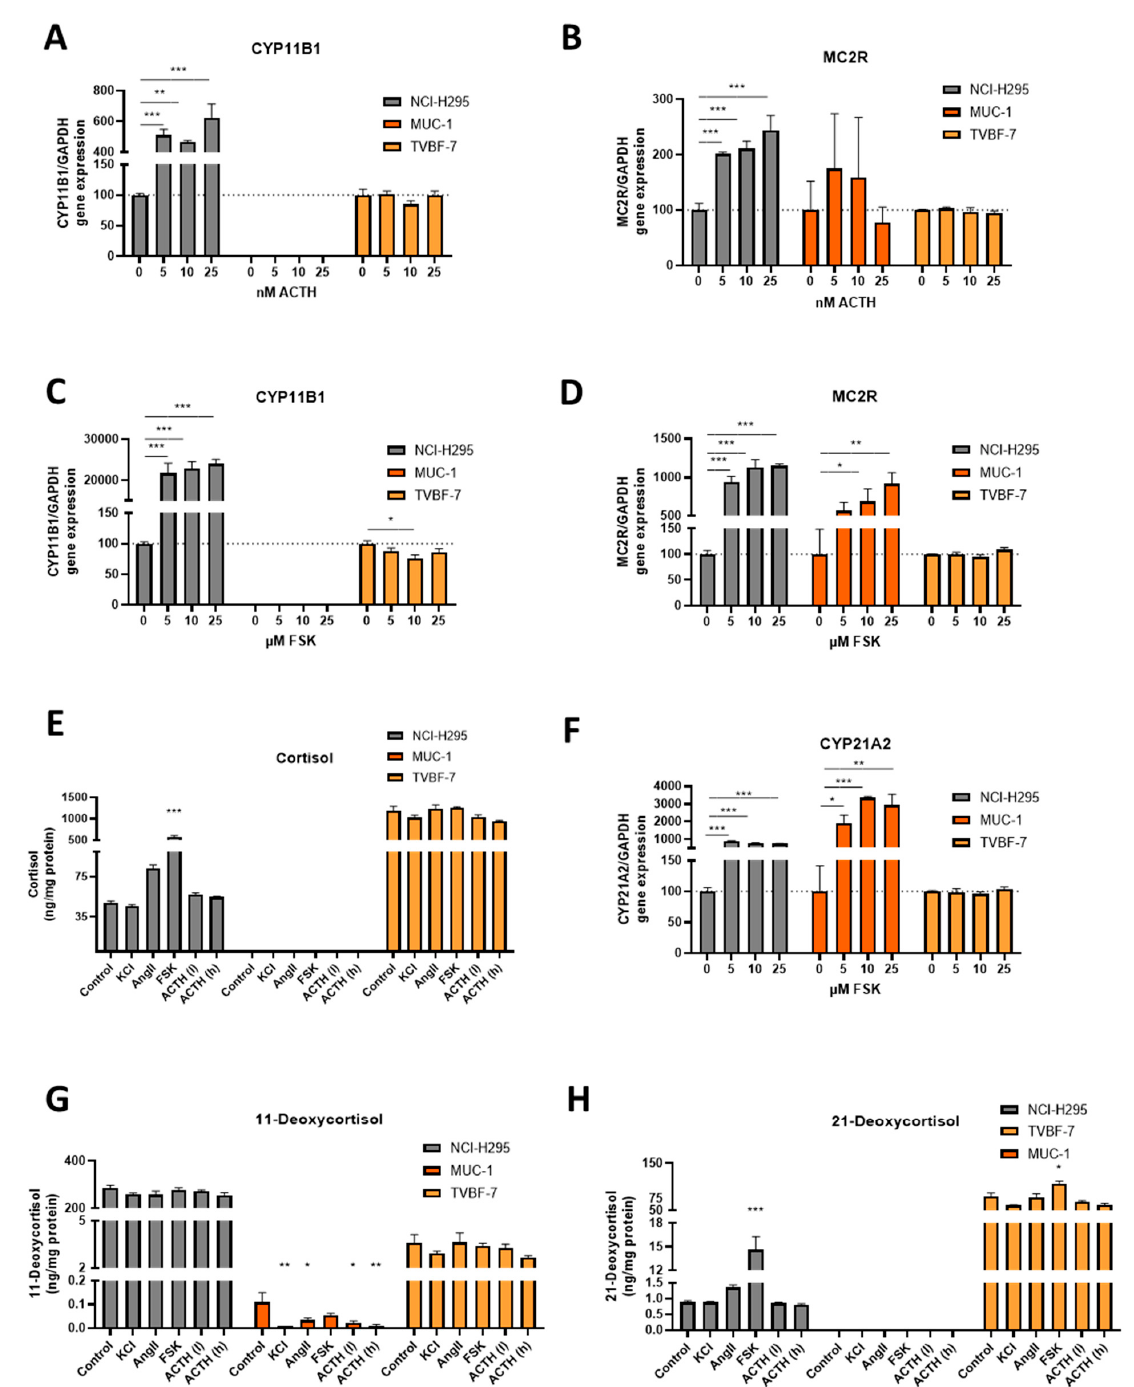
Figure 5. Activation of the glucocorticoid pathway upon different stimulations. CYP11B1 and MC2R gene expression upon ACTH ( A , B ) and FSK ( C , D ), respectively, per cell line. Hormonal production of cortisol ( E ) in ng per mg of total protein for unstimulated cells in comparison with KCl, AngII, FSK and two different ACTH stimulations. Activation of intermediate steroidogenesis steps upon different stimulations. CYP21A2 gene expression upon FSK stimulation ( F ) per cell line. Hormonal production of 11- ( G ) and 21-deoxycortisol ( H ) in ng per mg of total protein for unstimulated cells in comparison with KCl, AngII, FSK and two different ACTH stimulations. Stars represent significance vs. untreated cells (* p < 0.05; ** p < 0.01; *** p < 0.001).